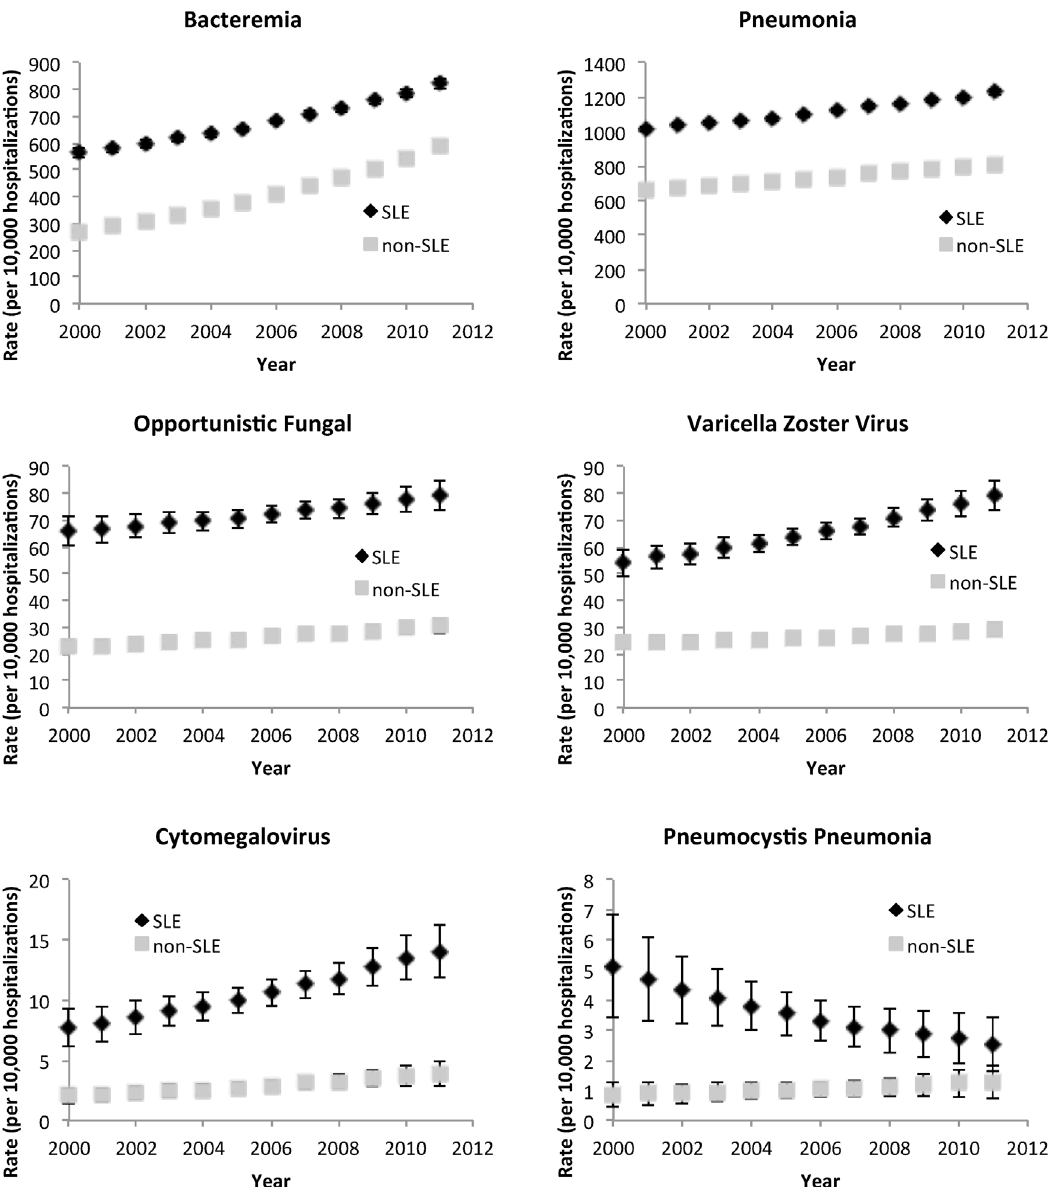
Fig 1. Annual adjusted rates of specific infections per 10,000 hospitalizations, among hospitalizations with SLE compared with non-SLE hospitalizations, between 2000 and 2011 in the NIS. Annual rates of infections are adjusted for age, gender, race/ethnicity, and a modified Charlson